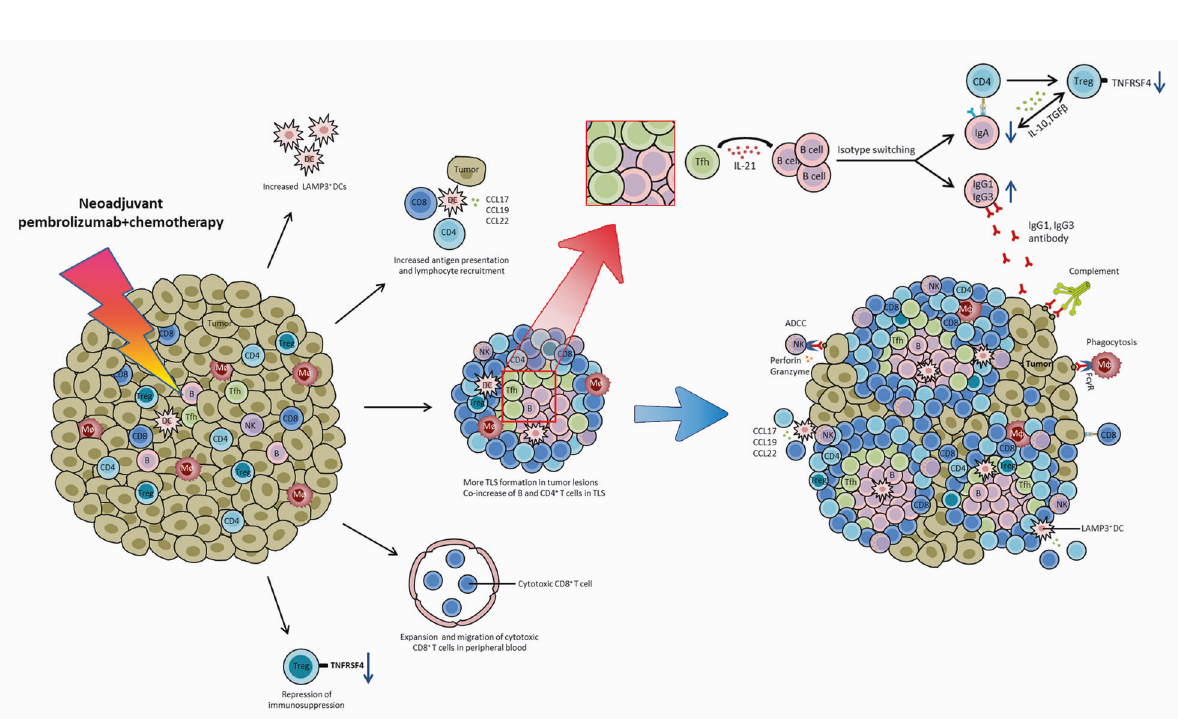
Fig. 8 Summary of key anti-tumor events occurring during neoadjuvant chemoimmunotherapy. Neoadjuvant chemoimmunotherapy promotes LAMP3 + DCs aggregation in tumor lesions, and the increased LAMP3 + DCs acquire tumor antigen, migrate and interact with lymphocytes, and participate in the activation, recruitment, and regulation of T/B lymphocytes through L-R interactions. Anti-PD-1 therapy reinvigorates the expansion of intratumoral CD4 + T cells and peripheral cytotoxic CD8 + T clones and promoted CD8 + T cells migration